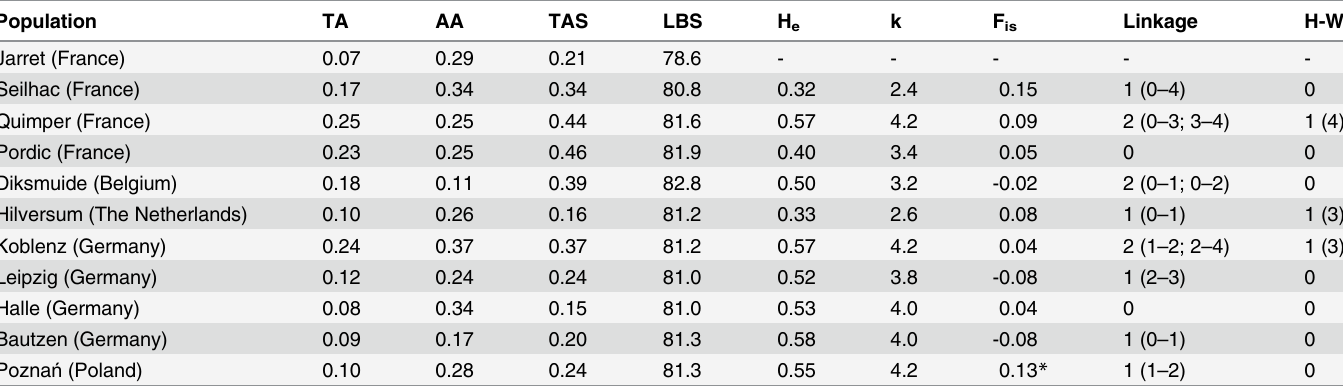
Table 2. Basic statistics for the sampled populations of H . subterraneus